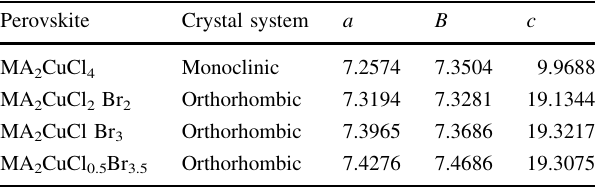
Table 9 Crystal structure and lattice parameters of Cu-based perovskites Perovskite Crystal